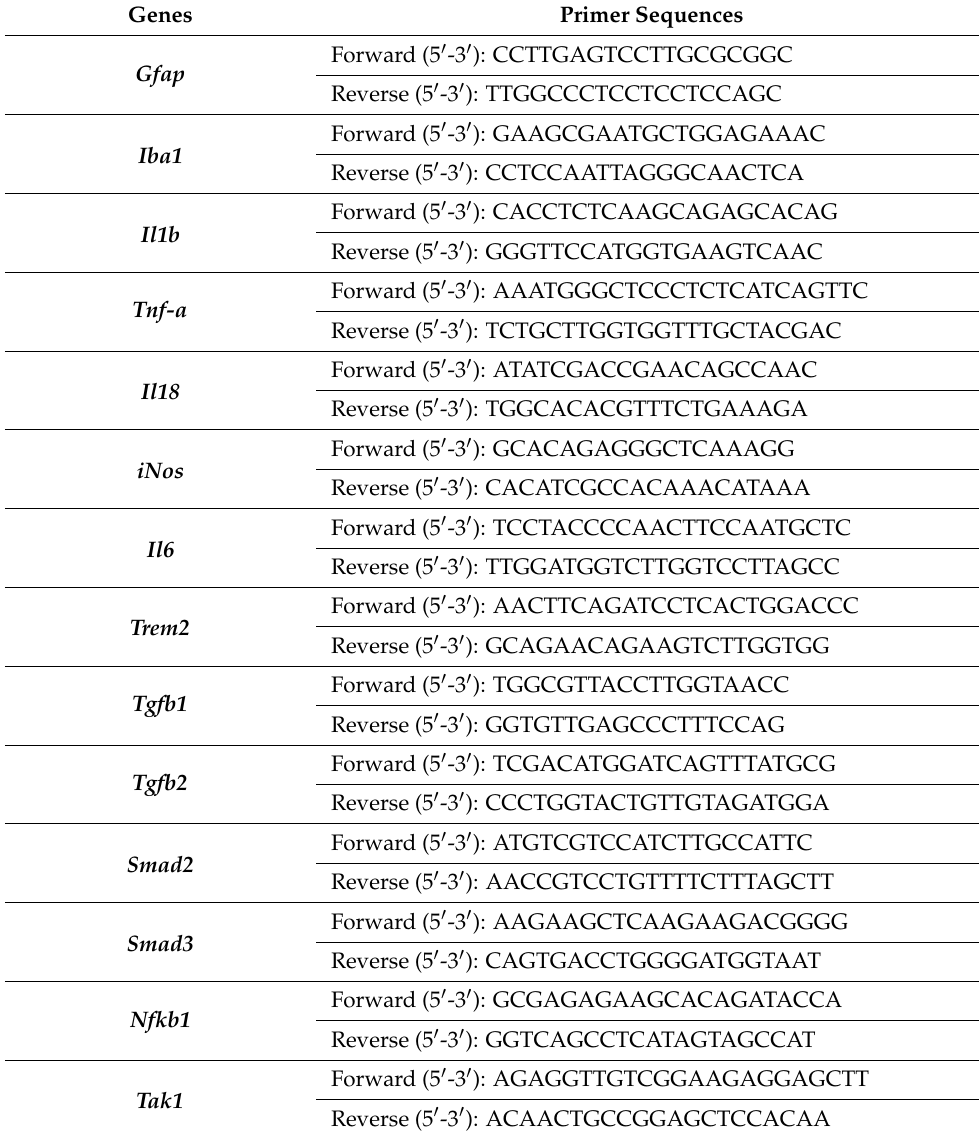
Table 1. The primer sequences used in the real-time quantitative PCR. Genes Primer